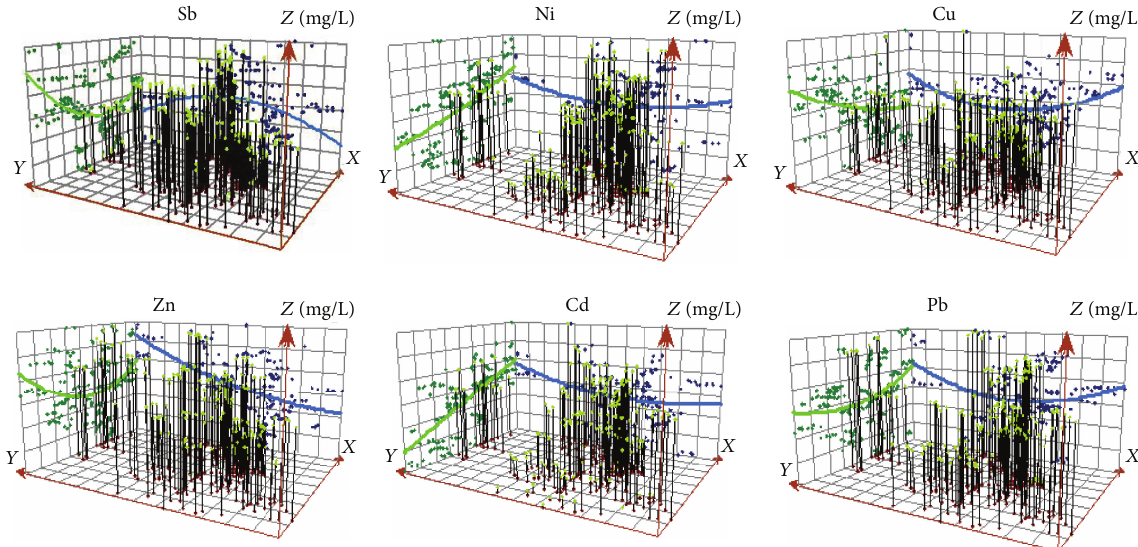
Figure 4: The spatial structures of Sb, Ni, Cu, Zn, Cd, and Pb in surface runoff in the antimony